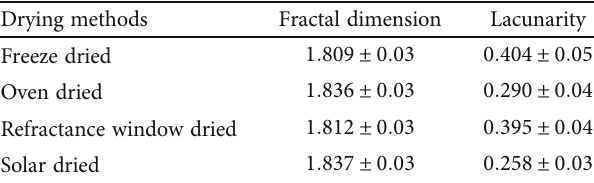
Figure 10: Cross-section microstructure (117 × mag) of jackfruit dried using di ff erent drying methods and their respective grey-level intensity plots: (a) Freeze-dried (FD); (b) oven-dried (OD); (c) refractance window dried (RWD); (d) solar dried (SD). Table 6: Fractal dimension and lacunarity of jackfruit dried with di ff erent